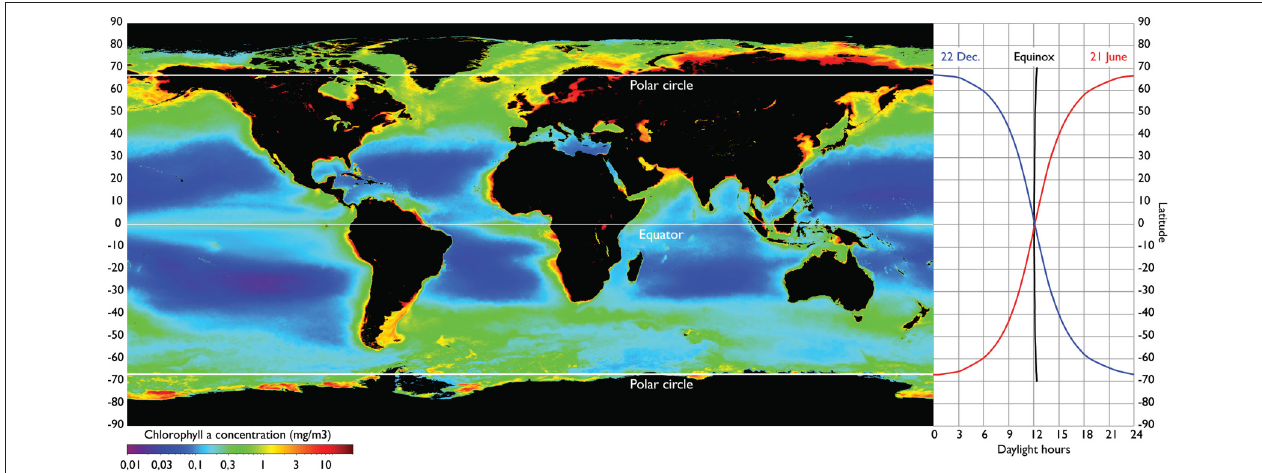
FIGURE 1 | The seasonal light cycle strongly structures the phytoplankton production at high latitudes, and this effect cascades to higher trophic levels. Right panel shows latitudinal variation in daylight length for the two solstices (about 21 June and 22 December) and for the two equinoxes (about 20 March and 22 September). The source of the global map of annual mean chlorophyll concentration is from SeaWIFS satellite sensor averaged over the interval 4 September 1997–30 November 2010 ( left panel ).